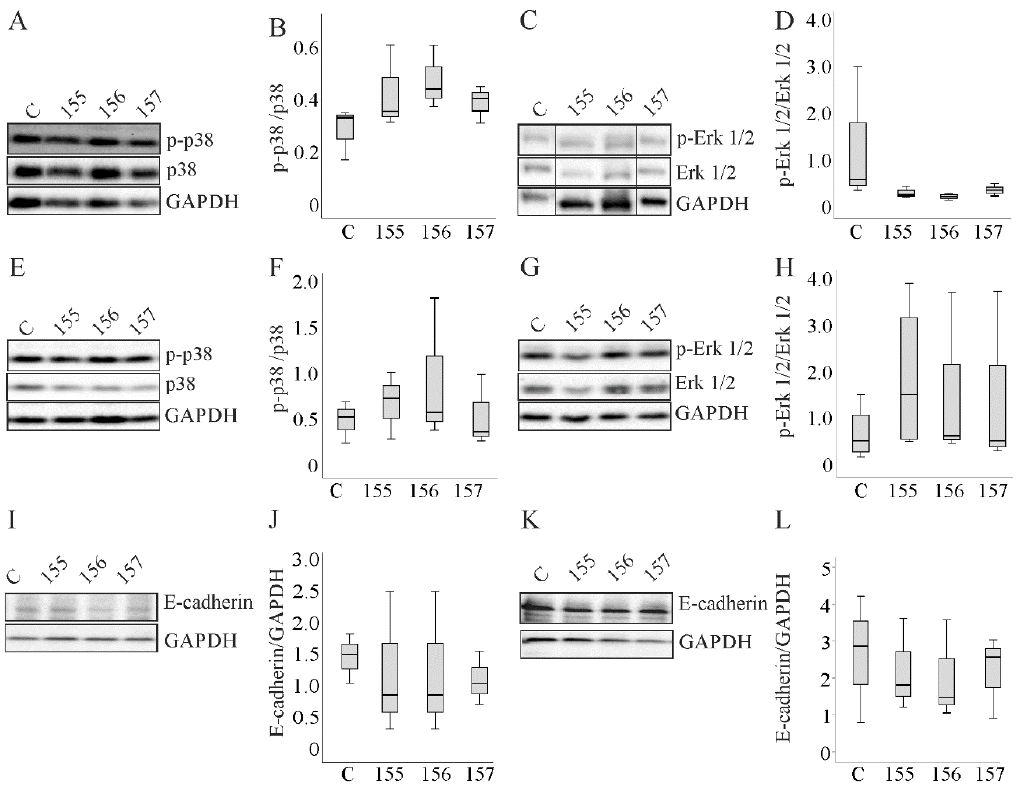
Figure 6. Expression of E-cadherin and p38 MAPK and ERK1 / 2 and the phosphorylated (p-)forms of the kinases in Huh7 and HepG2 cells. ( A ) p38 and p-p38 MAPK in Huh7 cells overexpressing chemerin isoforms. ( B ) Ratio of p-p38 to p38 MAPK in these cells. ( C ) ERK1 / 2 and p-ERK1 / 2 in Huh7 cells overexpressing chemerin isoforms. Bands are from a single image and were sorted in the same order as the other immunoblots shown. ( D ) Ratio of p-ERK1 / 2 to ERK1 / 2 in these cells. ( E ) p38 and p-p38 MAPK in HepG2 cells overexpressing chemerin isoforms. ( F ) Ratio of p-p38 to p38 MAPK in these cells. ( G ) ERK1 / 2 and p-ERK1 / 2 in HepG2 cells overexpressing chemerin isoforms. ( H ) Ratio